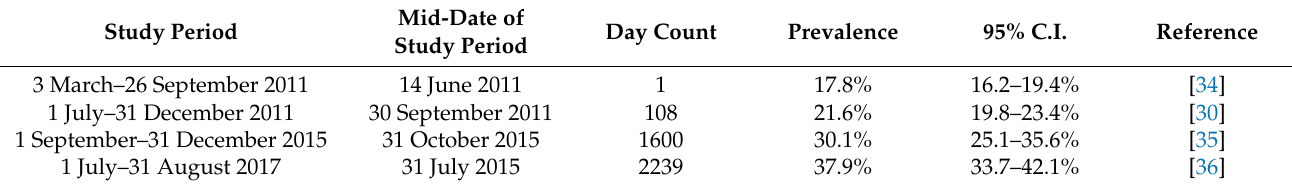
Table 6. Point-prevalence of MRSA in Hong Kong nursing homes.